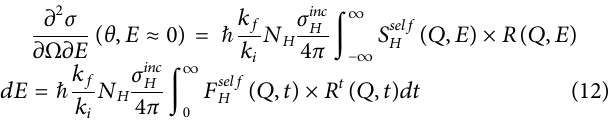
Frontiers in Chemistry |